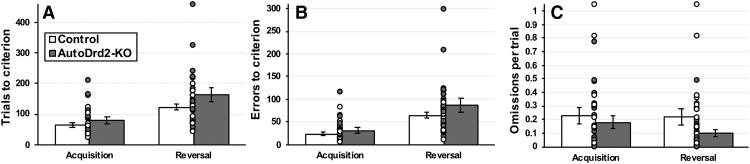
Trials to criterion, errors to criterion and omission rates. Although there was no effect of genotype on the number of trials needed to reach criterion, testing the specific hypothesis of a slower performance in autoDrd2-KO during the reversal phase with a t test returned a probability closely approaching significance level (p = 0.051; A). There was no statistically significant difference between the groups in the total numbers of errors committed (B) or in the number of omissions per trial (C). Each dot represents a single data point. Bars show group means ± SEM.